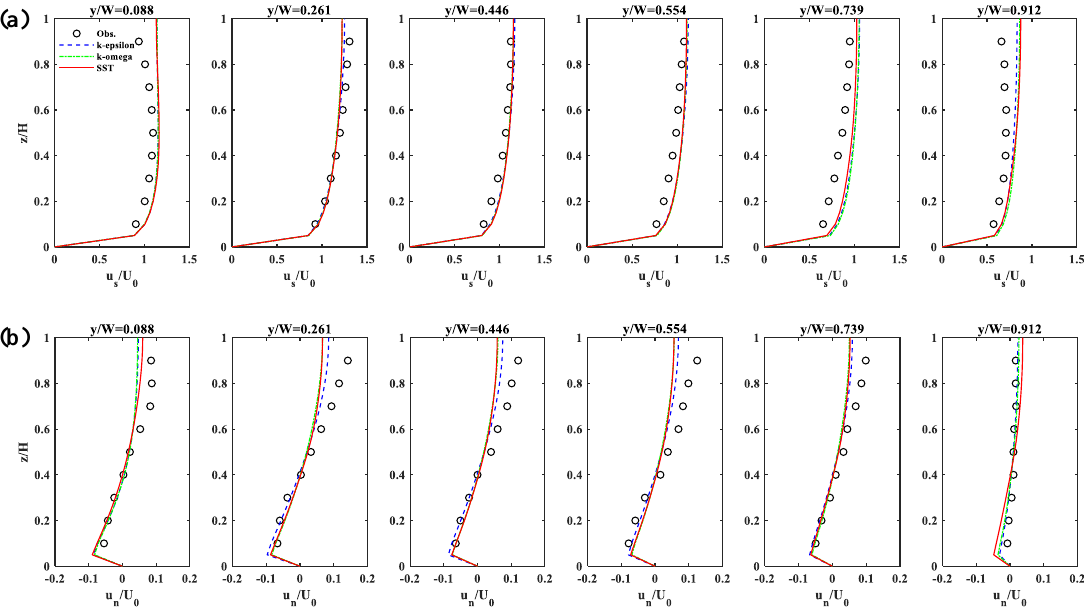
Figure 2. Comparison between observation of Chang’s experiments and simulations with three turbulence models: ( a ) streamwise velocity profiles and ( b ) spanwise velocity profiles. y / W and z / H denote the dimensionless distance from the left bank and channel bed, respectively.